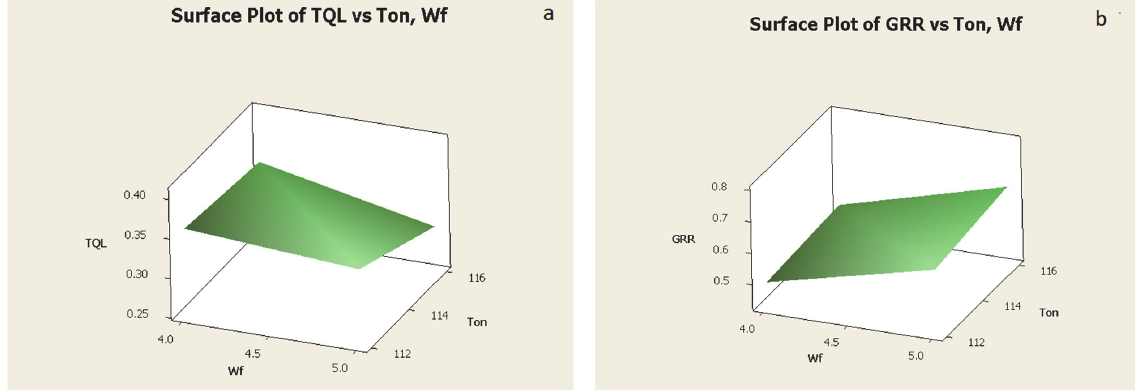
Fig. 4. (a). Surface plot for Taguchi Quality loss with input parameters; 4(b) Surface plot for Desirability with Grey Taguchi with input